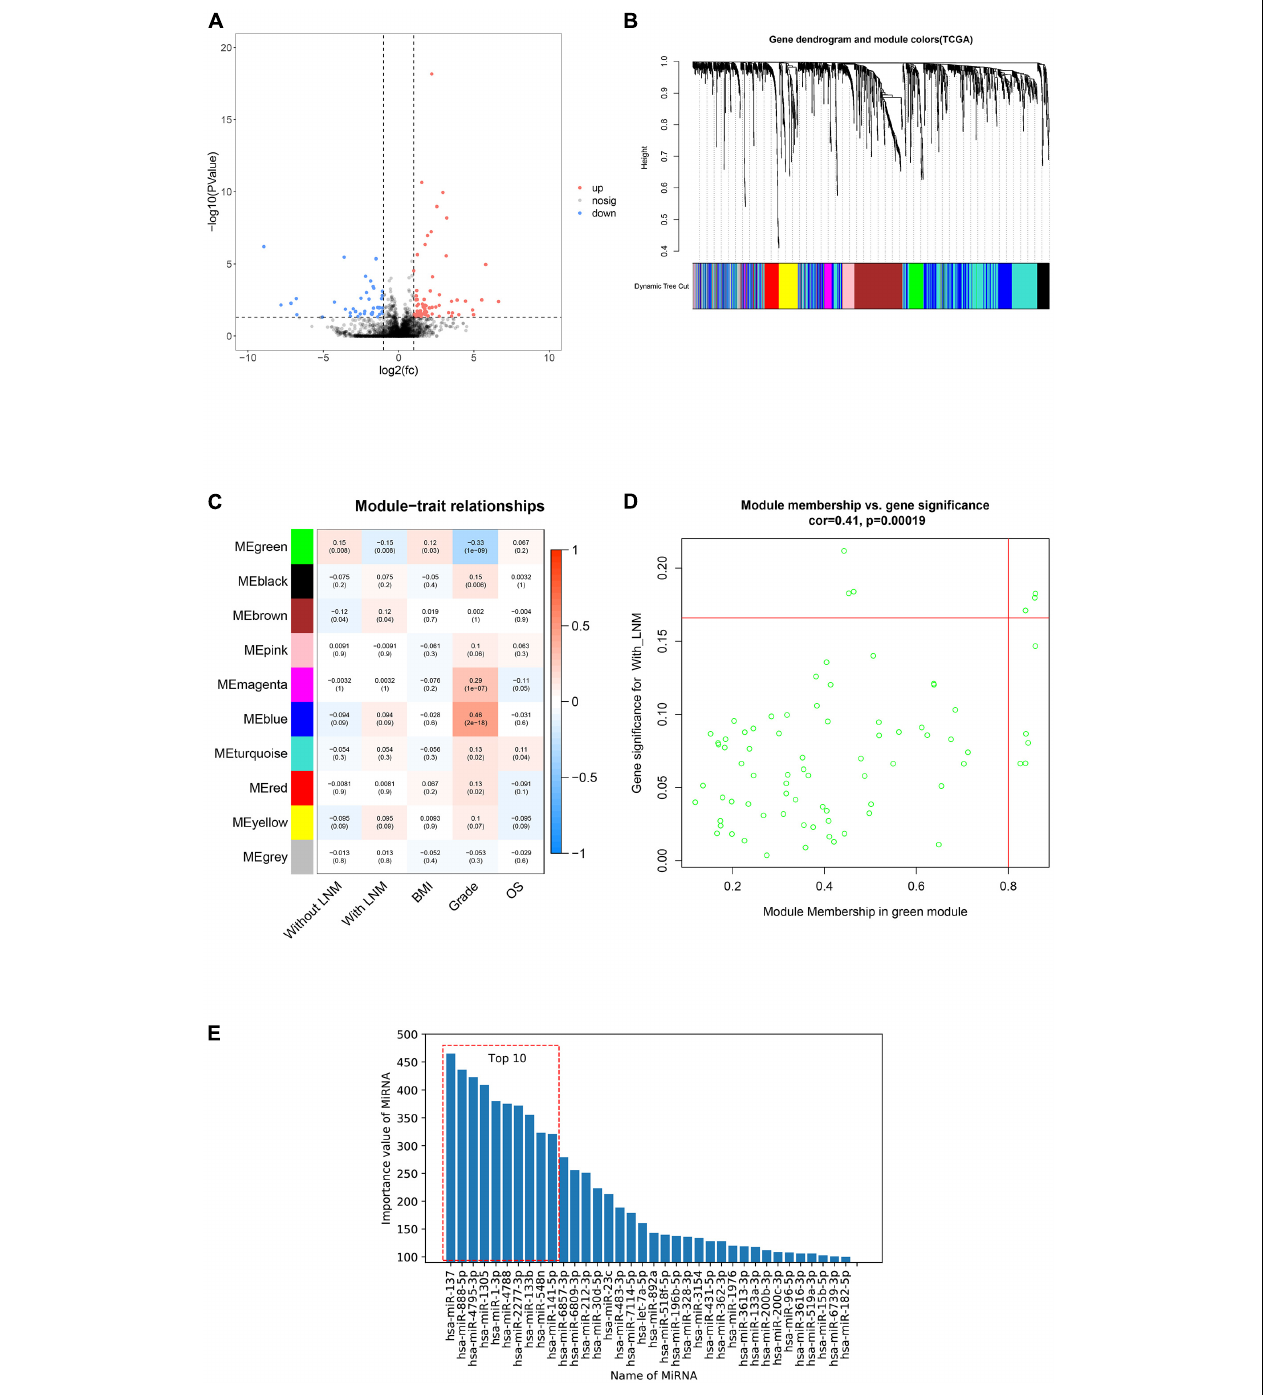
FIGURE 2 | Candidate miRNAs screening by three methods. This figure describes the screening of candidate miRNAs by three methods. (A) Volcano plot of differentially expressed miRNAs between patients with lymph node metastasis (LNM) and without LNM. Red dots represented upregulated miRNAs, blue dots represented downregulated miRNAs, and black dots represented no significance. (B) Dendrogram of genes clustered based on dissimilarity measure. The upper panel showed the gene dendrogram, and the lower panel showed 10 gene modules displayed in different colors. (C) Heat map of the correlation between modules and clinical features. The number above each cell represented the correlation between the module and the feature, and the number below each cell represented the corresponding p value. Red represented a positive correlation, and blue represented a negative correlation. (D) Scatter plot showed the correlation between gene significance (GS) and module membership (MM) in the green modules. (E) The importance value of miRNAs in Gradient Boosting Decision Trees (GBDTs) by decision tree.